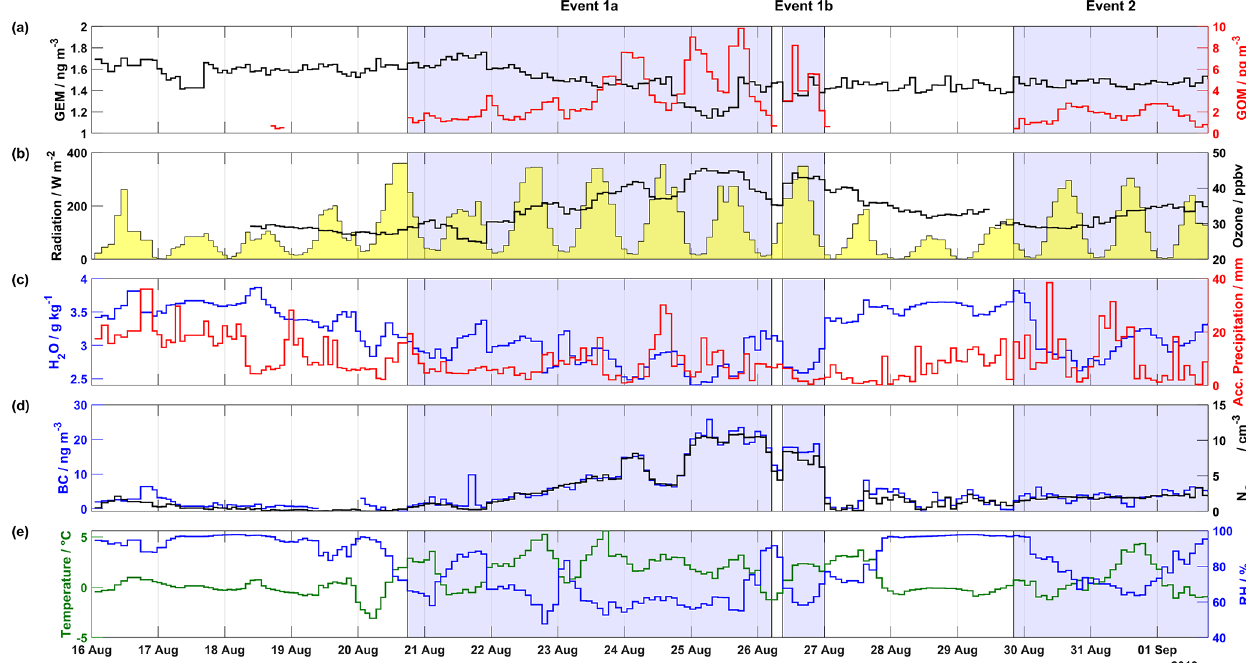
Figure 1. Overview of mercury, meteorological parameters, ozone, and aerosol properties (BC and N Coarse ) measured during the 2019 cam- paign, including (a) GEM (ngm − 3 ) in black on the left axis and GOM (pgm − 3 ) in red on the right axis, (b) radiation (Wm − 2 ) shaded in yellow on the left axis and ozone (ppbv) in black on the right axis, (c) H 2 O mixing ratio (gkg − 1 ) at ground level in blue on the left axis and accumulated precipitation (mm) in red on the right axis, (d) BC (ngm − 3 ) in blue on the left axis and N Coarse (cm − 3 ) in black on the right axis, and (d) temperature ( ◦ C) in green on the left axis and relative humidity (%) in blue on the right axis. The areas shaded in blue indicate Events 1a, 1b, and